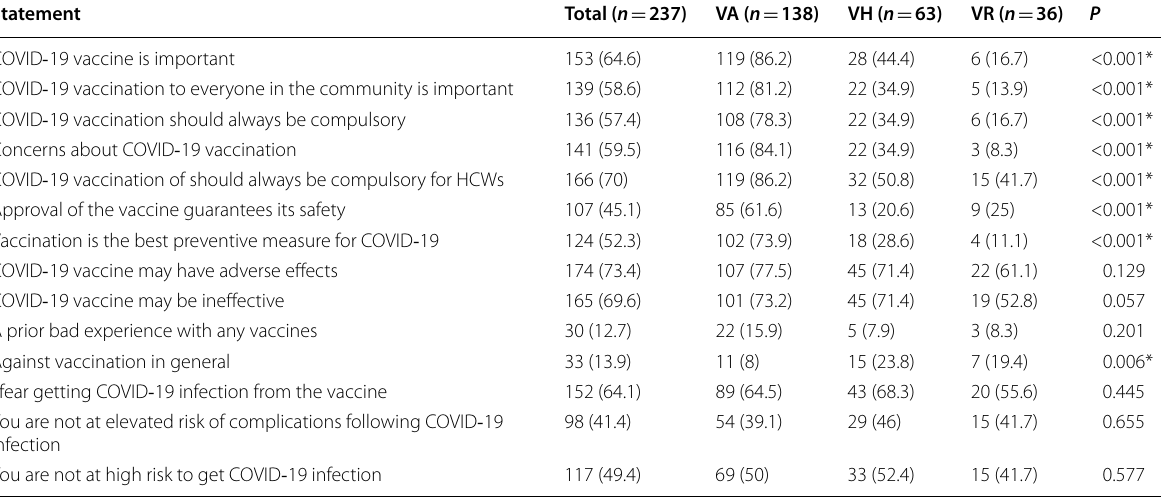
Table 3 Beliefs of hemodialysis patients regarding COVID ‐ 19 vaccination ( n